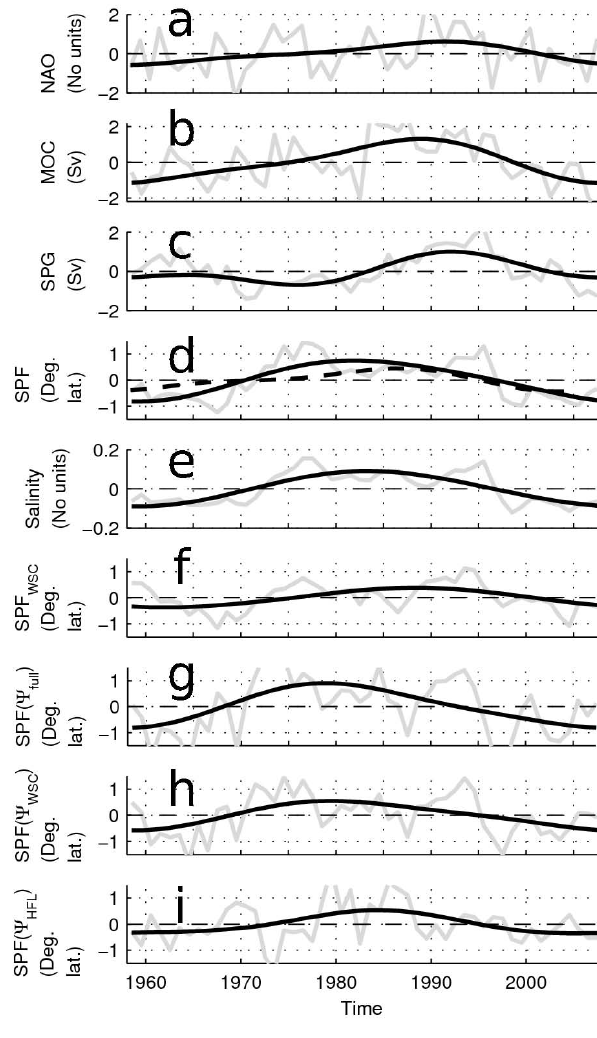
Fig. 4. Anomalies of annual averaged (grey curves) and low-pass filtered (black curves) indices used in the present study: NAO (panel a; no units), MOC intensity at 47 ◦ N (panel b; Sv), SPG intensity (panel c; Sv), SPF index of full forcing experiment (panel d; degrees of latitude), mean salinity in the frontal region of the NFB (panel e; no units), SPF index of WSC component (panel f; degrees of lati- tude) and SPF index calculated with the isoline of zero stream func- tion for the full forcing experiment (panel g), WSC (panel h) and HFL components (panel i; degrees of latitude in the three cases). The thick dashed curve in panel d is the low-pass filtered SPF index from the